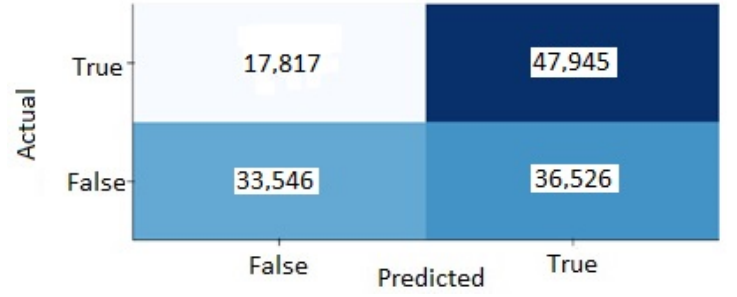
Figure 7. Confusion matrix of the third model.